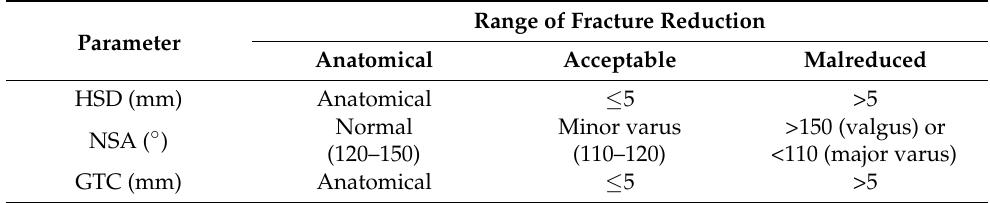
Table 1. Ranges of the three parameters for postoperative assessment of fracture reduction quality HSD, NSA and GT cranialization (GTC) according to the method of Schnetzke. Parameter